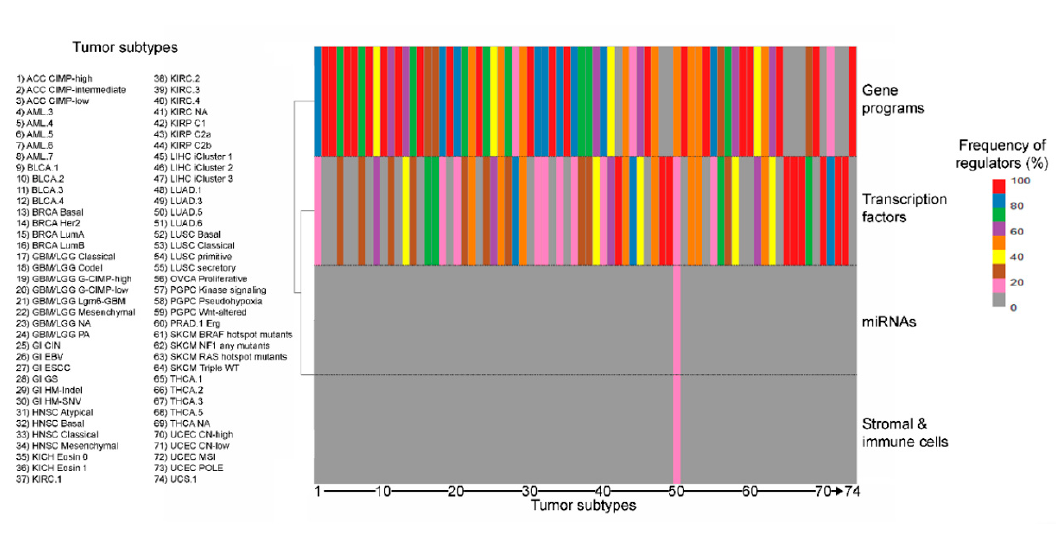
Figure 2. Distribution (%) of different classes of regulators (gene programs, transcription factors, miRNAs and stromal / immune content) for the landmark matrisome genes in the different tumor subtypes.